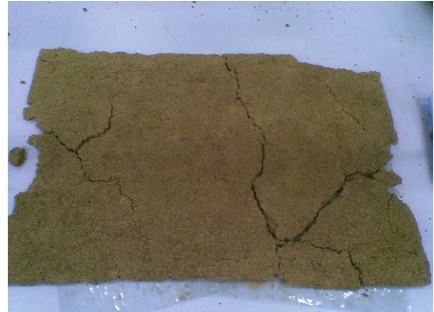
Figure 10: Propagation of crack due to the effect of high contents (greater than 70%) of the rice-husks on the structural stability of the rice husk-UPR